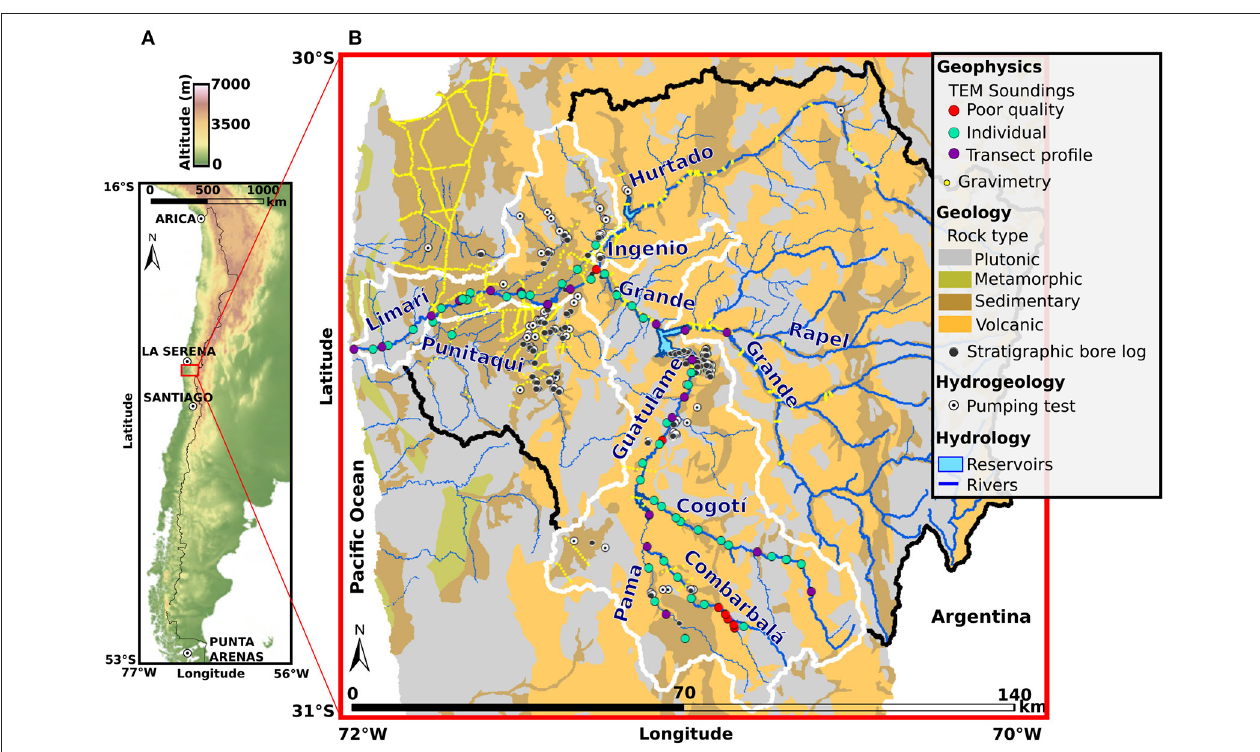
FIGURE 1 | Study area. (A) Overview map indicating the Limarí catchment location in north-central Chile. Elevation map from ASTER GDEM. (B) Detailed map of the Limarí catchment (black solid line) and of the area of study (white solid line) showing the main rivers and reservoirs as well as the geophysical, geological, and hydrogeological data locations. The geology map is from Servicio Nacional de Geología y Minería (2003), where the volcanic rock type includes volcanic-sedimentary